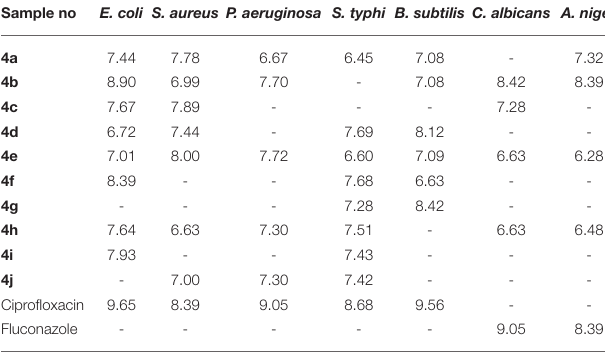
TABLE 4 | Minimum Inhibitory Concentration (MIC).